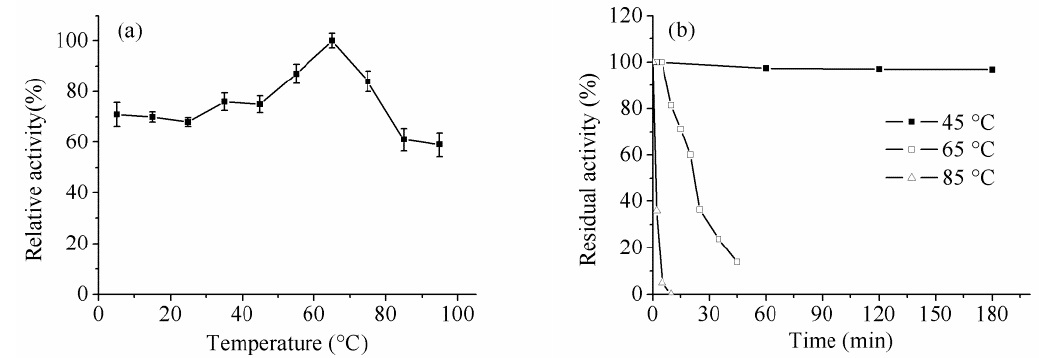
Figure 5. Effect of temperature on activity ( a ) and stability ( b ).